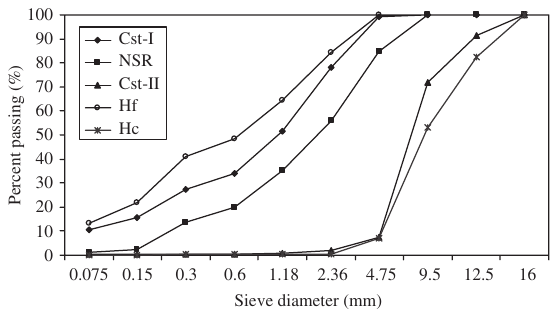
Figure 1 Particle size distributions of